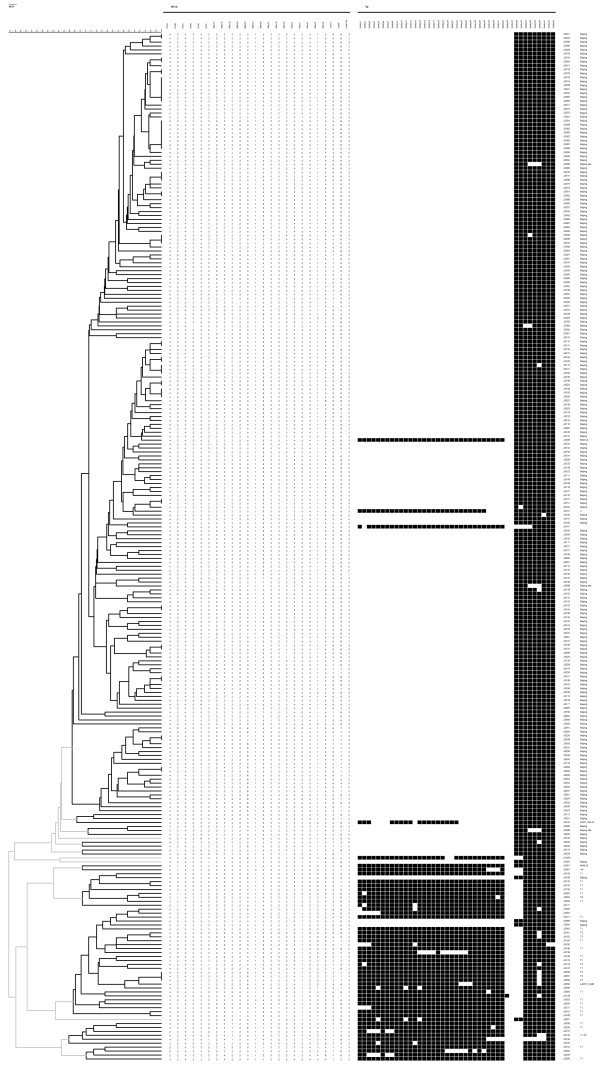
Samples with MIRU-VNTR and spoligotyping. Clustering was based upon an average of MIRU-VNTR and spoligotyping, clustered using the dice coefficient and the unweighted pair group method with arithmetic averages (UPGMA) in BioNumerics 5.0.